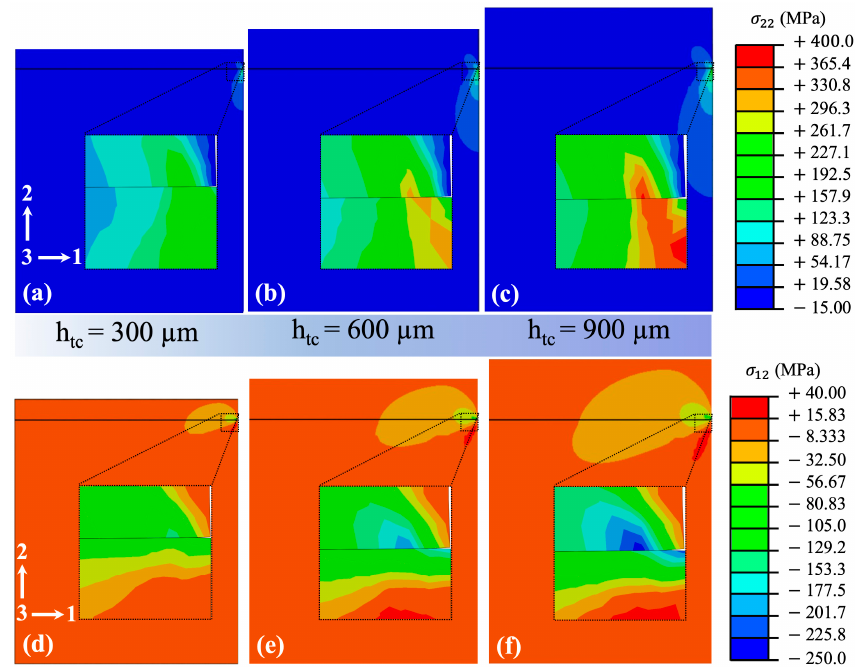
Figure 10. Effect of TC thickness on the stress distribution, tensile stress ( a ) 300 µ m thick TCs, ( b ) 600 µ m thick TCs, ( c ) 900 µ m thick TCs; and shear stress ( d ) 300 µ m thick TCs, ( e ) 600 µ m thick TCs, ( f ) 900 µ m thick TCs, the arrows mean the coordinate